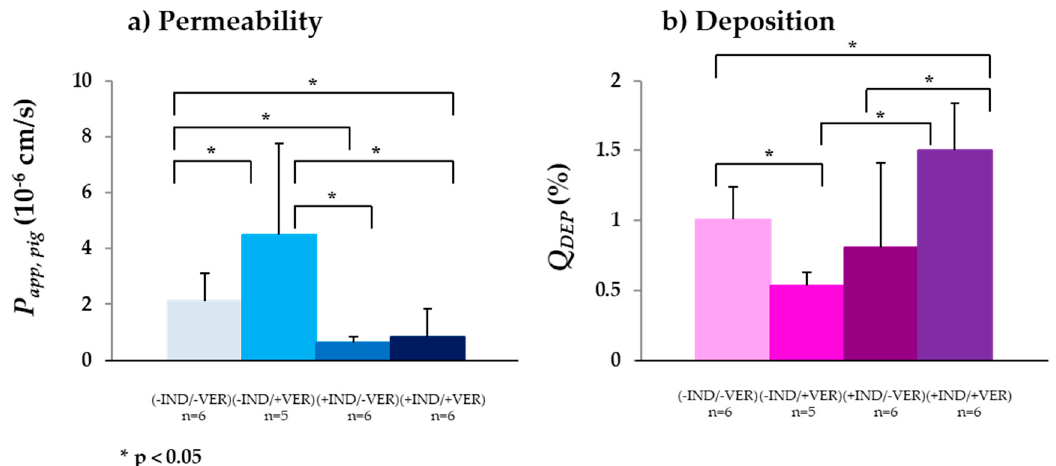
Figure 4. ( a ) P app pig and ( b ) Q DEP of fexofenadine in the absence ( − IND) / ( − VER) and presence ( + IND) / ( + VER) of the MRP3 inhibitors indomethacin (IND) and verapamil (VER) (mean ± SD; n = number of replicates).